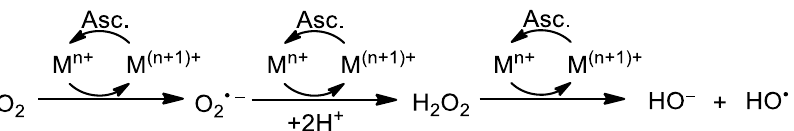
Figure 3. Production of hydroxyl radicals (HO • ) by metal redox cycling in the presence of oxygen and ascorbate (Asc.). Metal ion (M n + ) corresponds to Cu + or Fe 2 + .